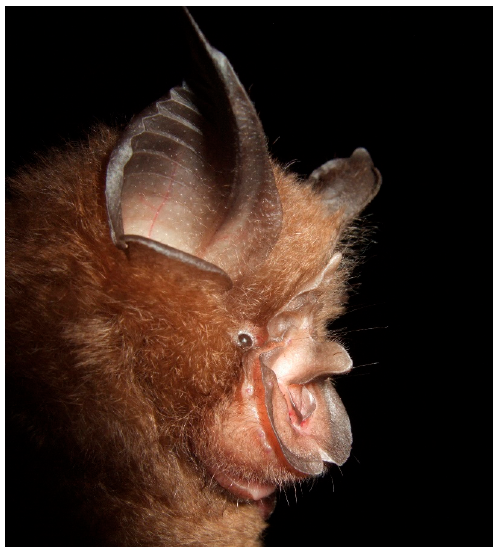
Figure 8. Rhinolophus pearsonii , adult male. Photograph by Vu Dinh Thong.